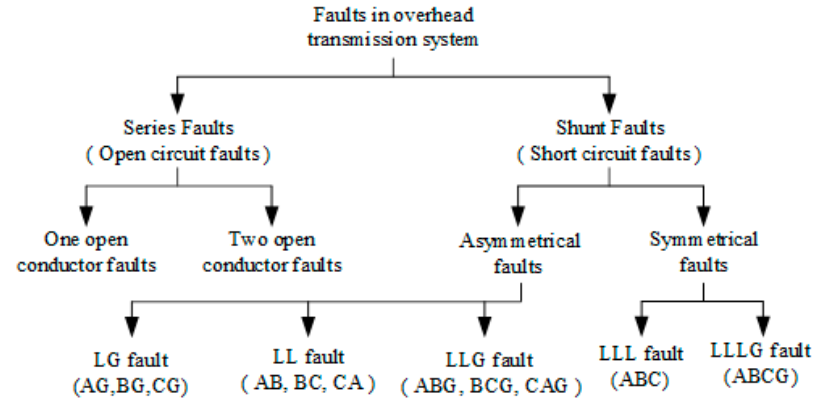
Figure 1. Various types of faults that can occur within three-phase power transmission